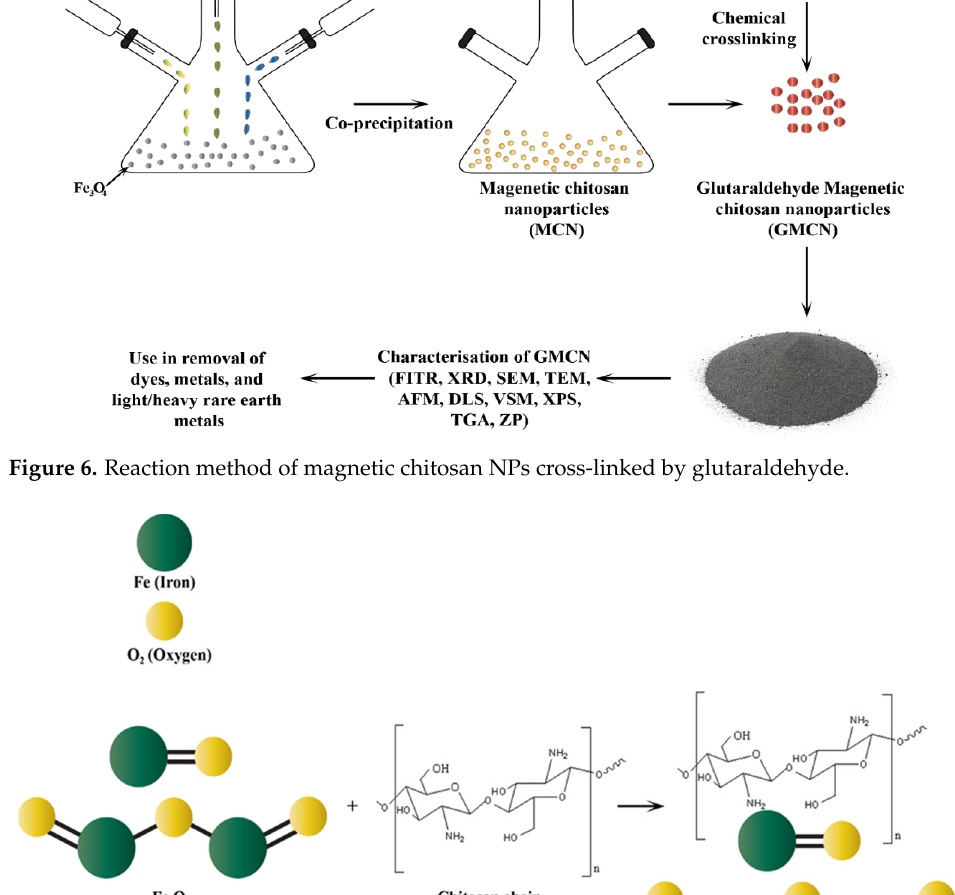
Table 1. Methods commonly used to characterize chitosan NPs .